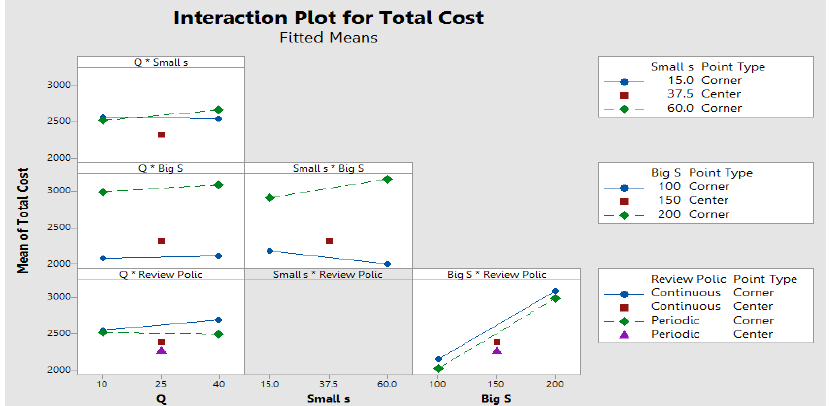
Figure 12. Interaction plot of full factorial design.